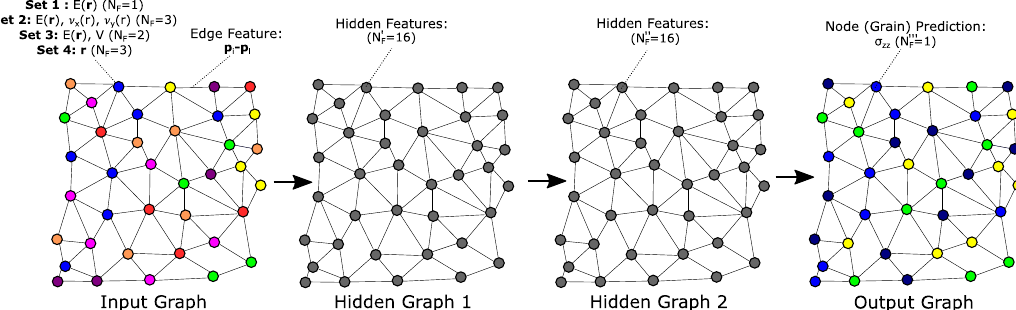
Fig. 10 Schematic of the GNN surrogate architecture used for this work. An input graph with various sets of nodal features maps to a fi nal output layer for predicting stress along the loading direction σ zz